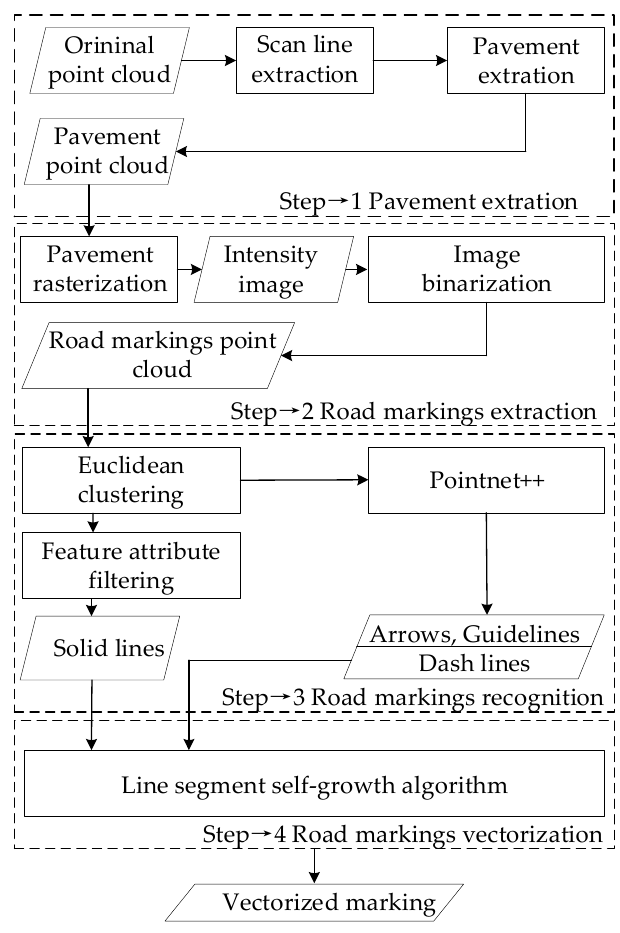
Figure 1. The flowchart of the data process of road markings.